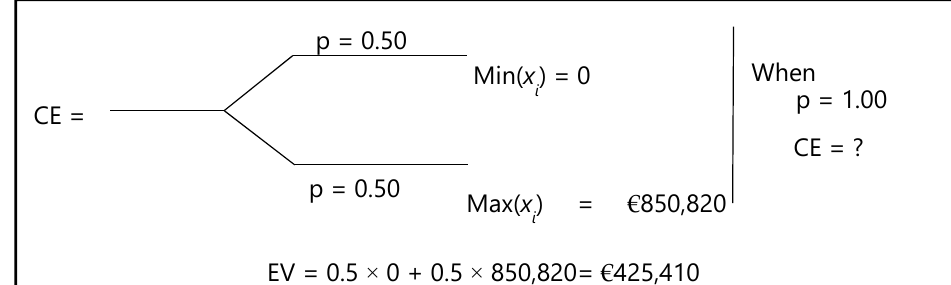
Figure 10. Lottery setup to discern utility values for user delay cost.